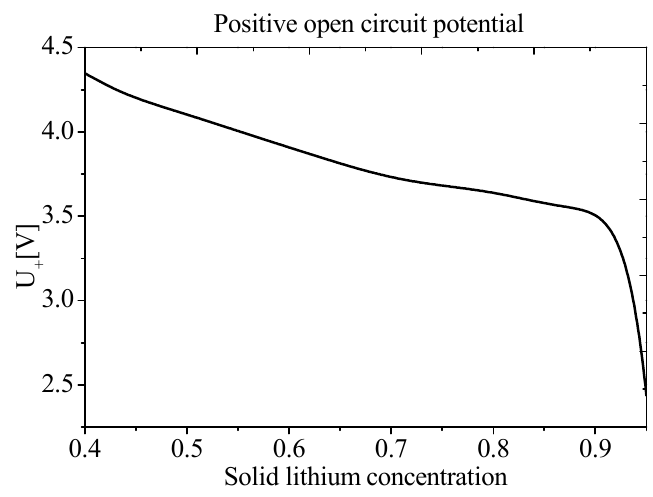
Figure 5. Positive open circuit potential.